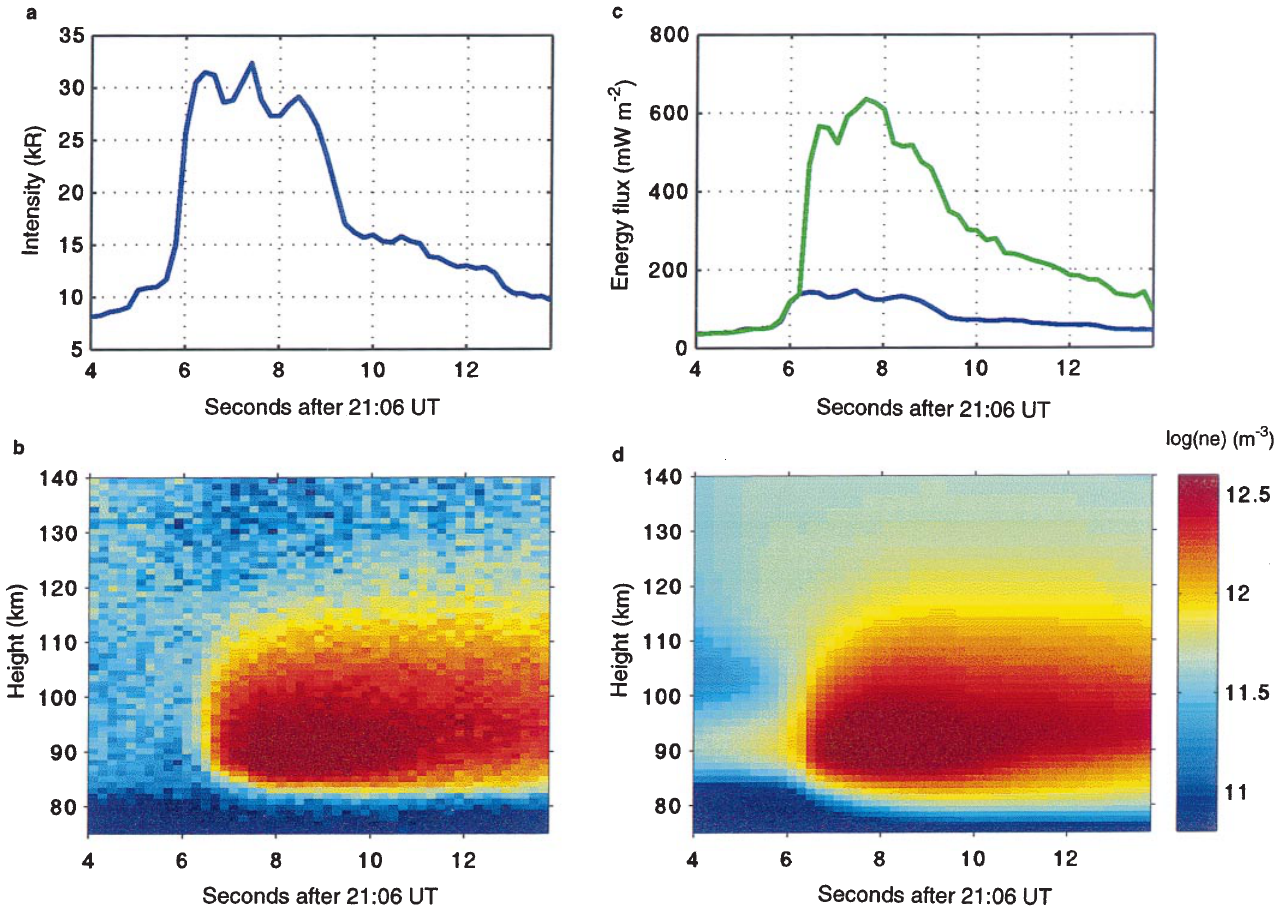
energy flux estimated from 427.8-nm emission rate as shown in a . Green curve is the energy flux required to produce the electron density profiles shown in d , which match the measured profiles well